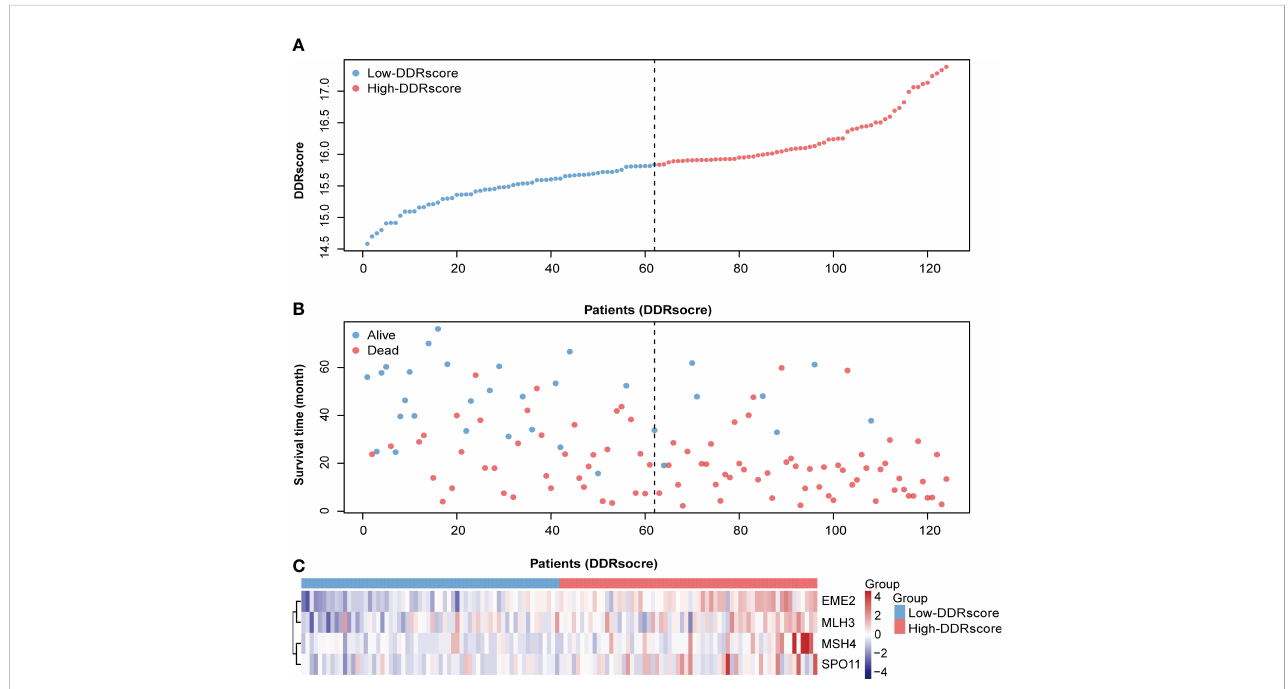
FIGURE 3 Distribution of metastatic colorectal cancer (mCRC) patients based on the DDRscore. (A) Risk curve for the DDRscore of each mCRC case. (B) Scatter plot for survival status of each mCRC case, red and blue dots represent death and survival, respectively. (C) Heatmap showing the expression pro fi les of four DDRs in the high- and low-DDRscore